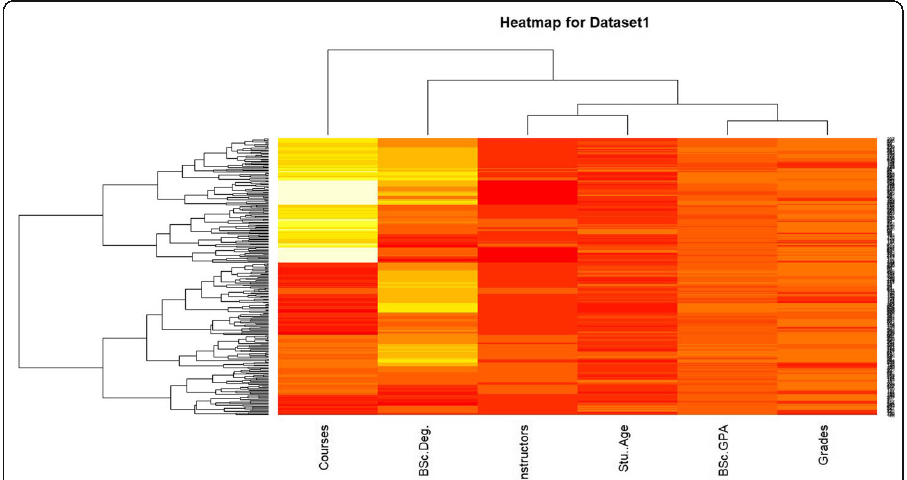
Fig. 5 Dataset 2 attributes and missing instances of